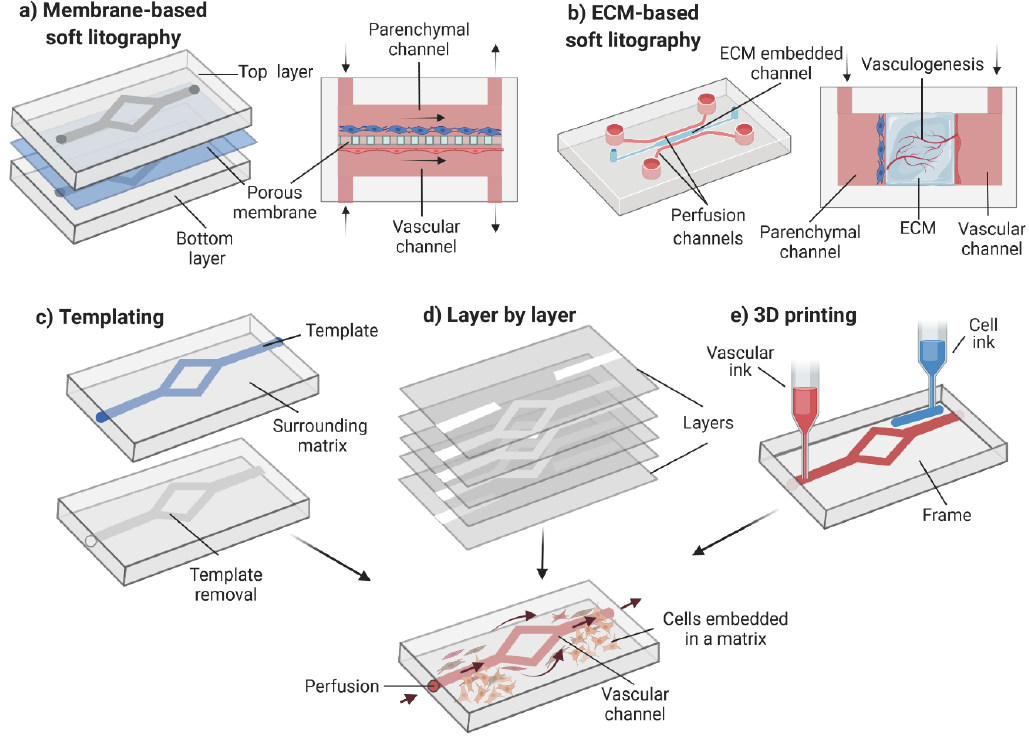
Figure 4. Schematic representation of techniques used to vascularize 3D OoC models. These tech- niques can be divided into soft-lithography and 3D patterning approaches. ( a ) Membrane-based soft lithography technique in which a porous membrane is sandwiched between two microfluidic layers. ( b ) ECM-based soft lithography in which one or more channels are filled with ECM, embedded between the parenchymal and vascular channels. ( c ) Templating approaches in which a matrix is cast around the template. The template is subsequently removed, generating hollow channels, which can be seeded and perfused. ( d ) Layer-by-layer approach consisting of assembled modular layers. ( e ) Three-dimensional printing (bioprinting) in which vascular and cell inks are used to generate a 3D tissue with embedded, perfusable vascular